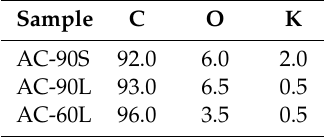
Table 2. Elemental chemical composition of the CNS-derived activated carbons, at%.